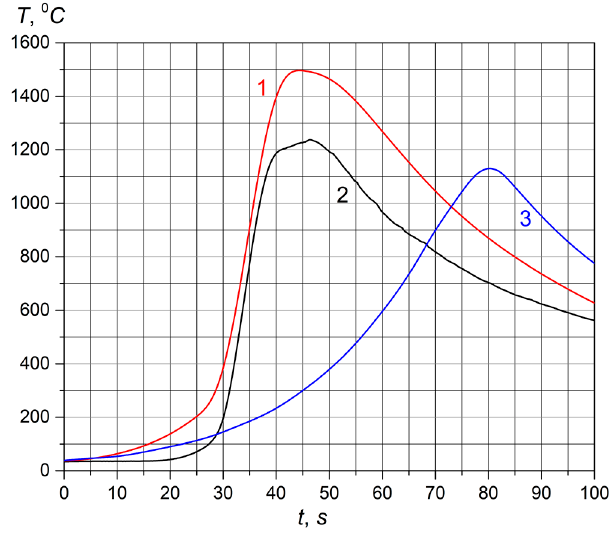
Figure 5. Temperature profiles at different argon content: q=12 cm 3 /(s·cm 2 ); 1—[N 2 ] = 100 %; 2—[Ar] = 12.8 %; 3—[Ar] = 24 %.